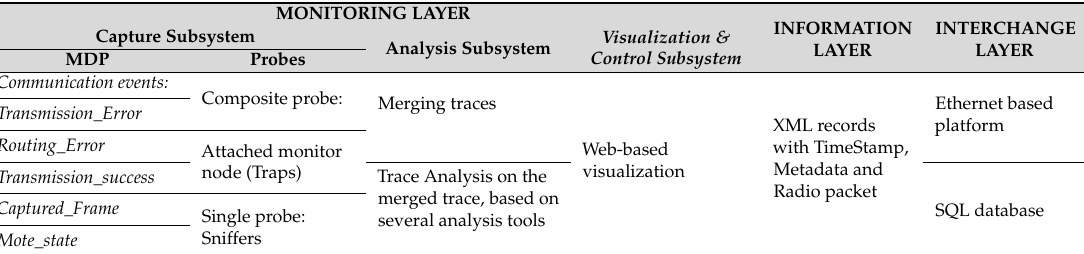
Table 3. Sample WSN-MP